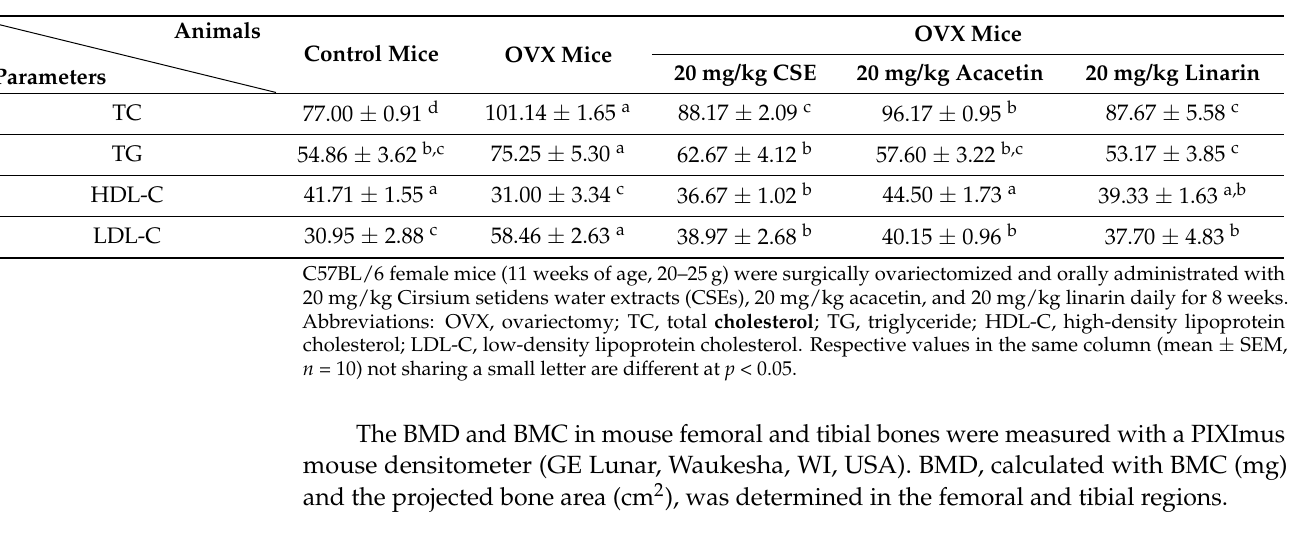
Table 3. Effects of CSEs, acacetin, and linarin on blood lipid profile of OVX